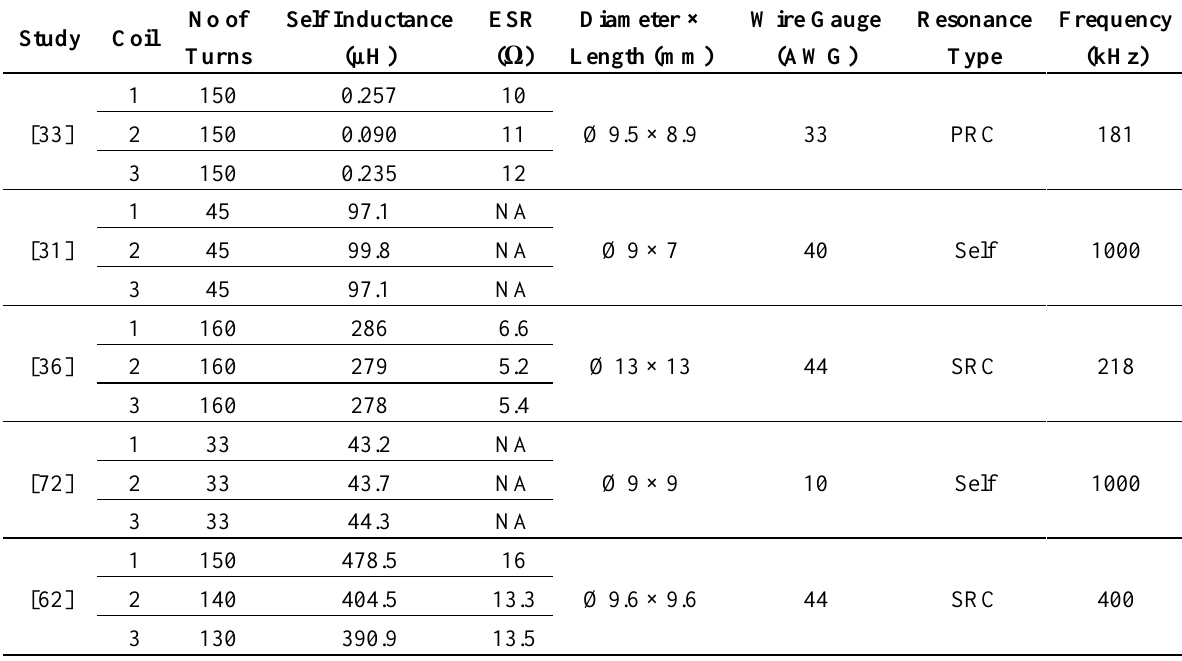
Table 2. The design parameters of receiving